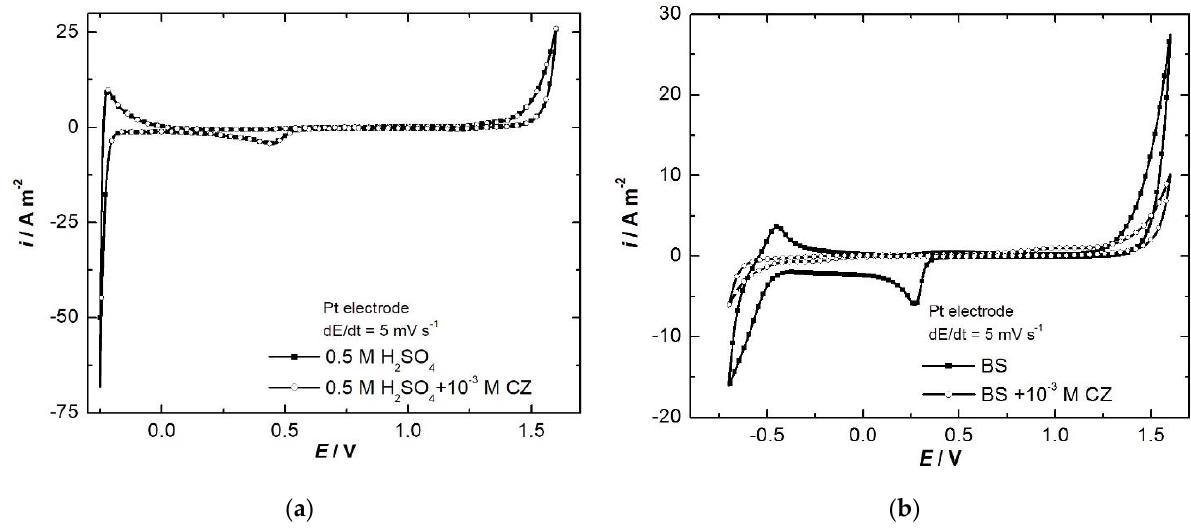
Figure 3. CVs (cycle 3) on platinum electrode 0.5 mol L − 1 H 2 SO 4 ( a ) and 0.5 mol L − 1 Na 2 SO 4 + 30 g L − 1 H 3 BO 3 (BS) ( b ) without and with 10 − 3 mol L − 1 CZ, at 5 mV s − 1 scan rate.